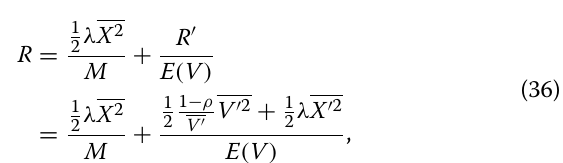
Fig. 6 Model of remaining service